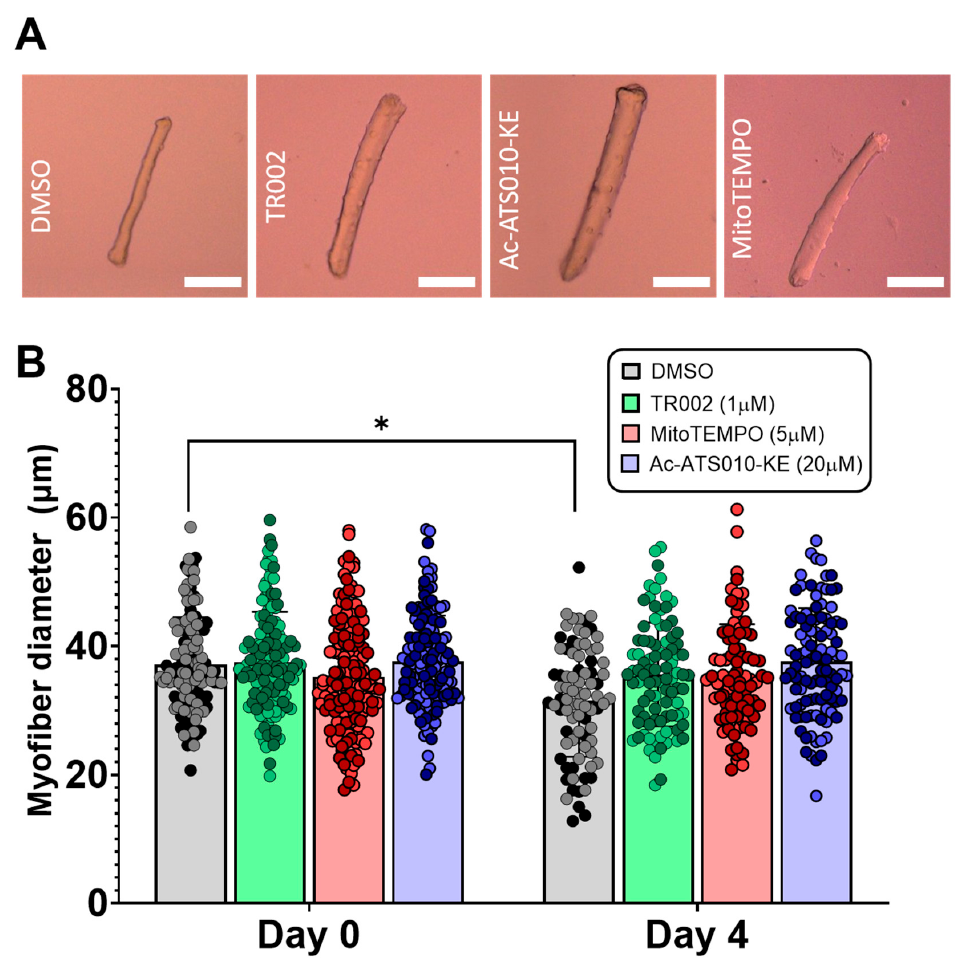
Figure 6. To determine if inhibition of MPT, mROS, or caspase-3 prevents atrophy in a single muscle fiber model of disuse atrophy, single isolated FDB myofibers were kept in culture conditions and treated with DMSO (vehicle control),1 µ M TR002 (MPT-inhibitor), 20 µ M Ac-ATS010-KE (caspase-3 inhibitor), or 5 µ M mitoTEMPO (mROS-inhibitor) for 4 days, and myofiber diameter was assessed pre- and post-treatment. ( A ) Representative images of isolated mouse FDB fibers following 4-days of treatment with DMSO, TR002, Ac-ATS010, or mitoTEMPO. Scale bars represent 100 µ m. Biological replicates ( n = 2) are identified by data points of different colors within a given treatment, while technical replicates share the same color data point. ( B ) Inhibition of MPT, caspase-3, and mROS all prevented change in myofiber diameter over the 4-day period, while the vehicle control group demonstrated a substantial decline in size. This indicates that inhibition of MPT, caspase-3, or mROS prevent atrophy in a culture model of skeletal muscle disuse. * p < 0.05